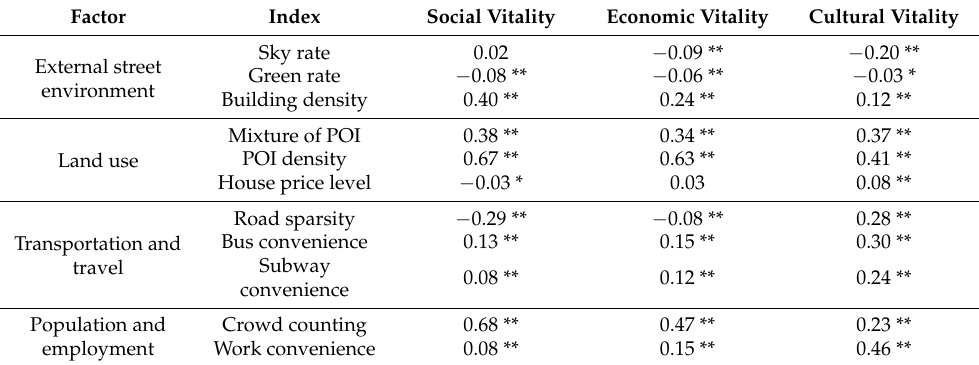
Table 3. Results of the correlation analysis between street built environment factors and social, economic and cultural